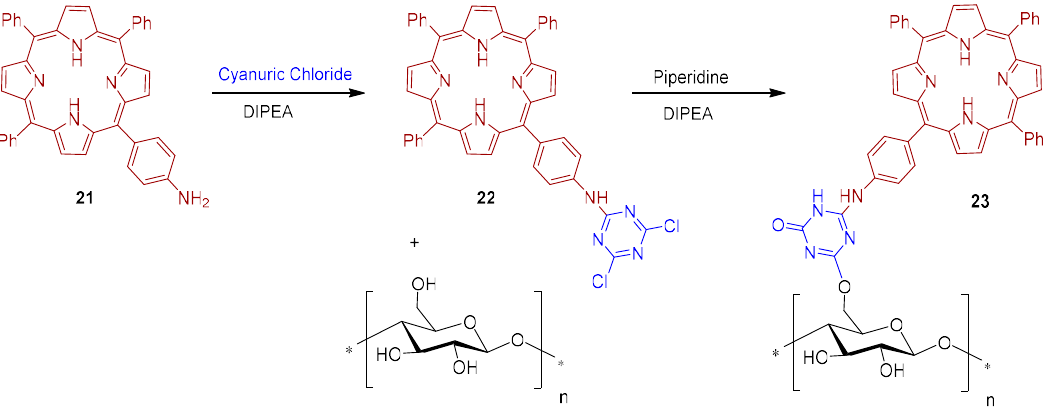
Figure 16. Synthetic methodology used to covalently graft 5-(4-aminophenyl)-10,15,20-tri- phenylporphyrin 21 on cellulose fabrics (cotton) via cyanuric chloride as grafting agent (Adapted from reference [158]